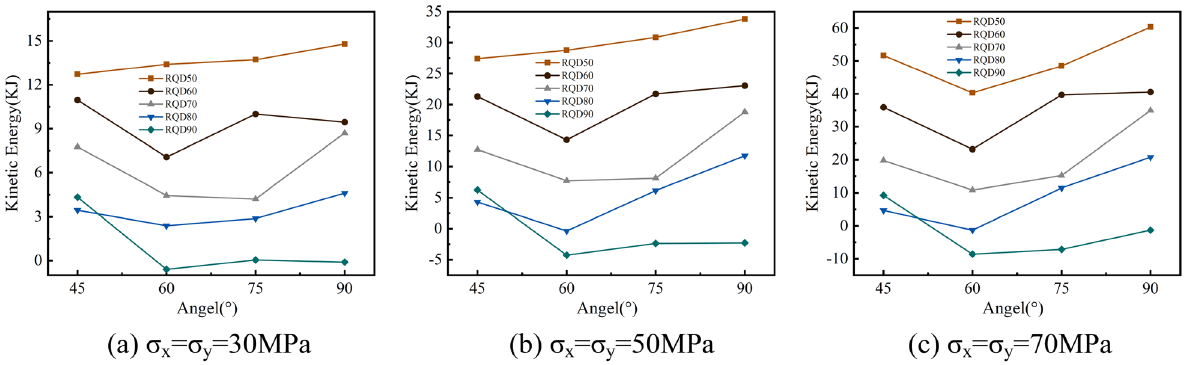
Fig. 22 KE' with different θ , RQD and in-situ